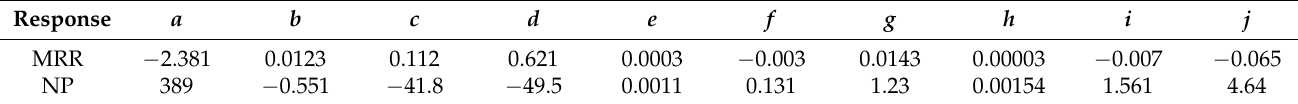
Table 5. Regression coefficients for MRR and NP